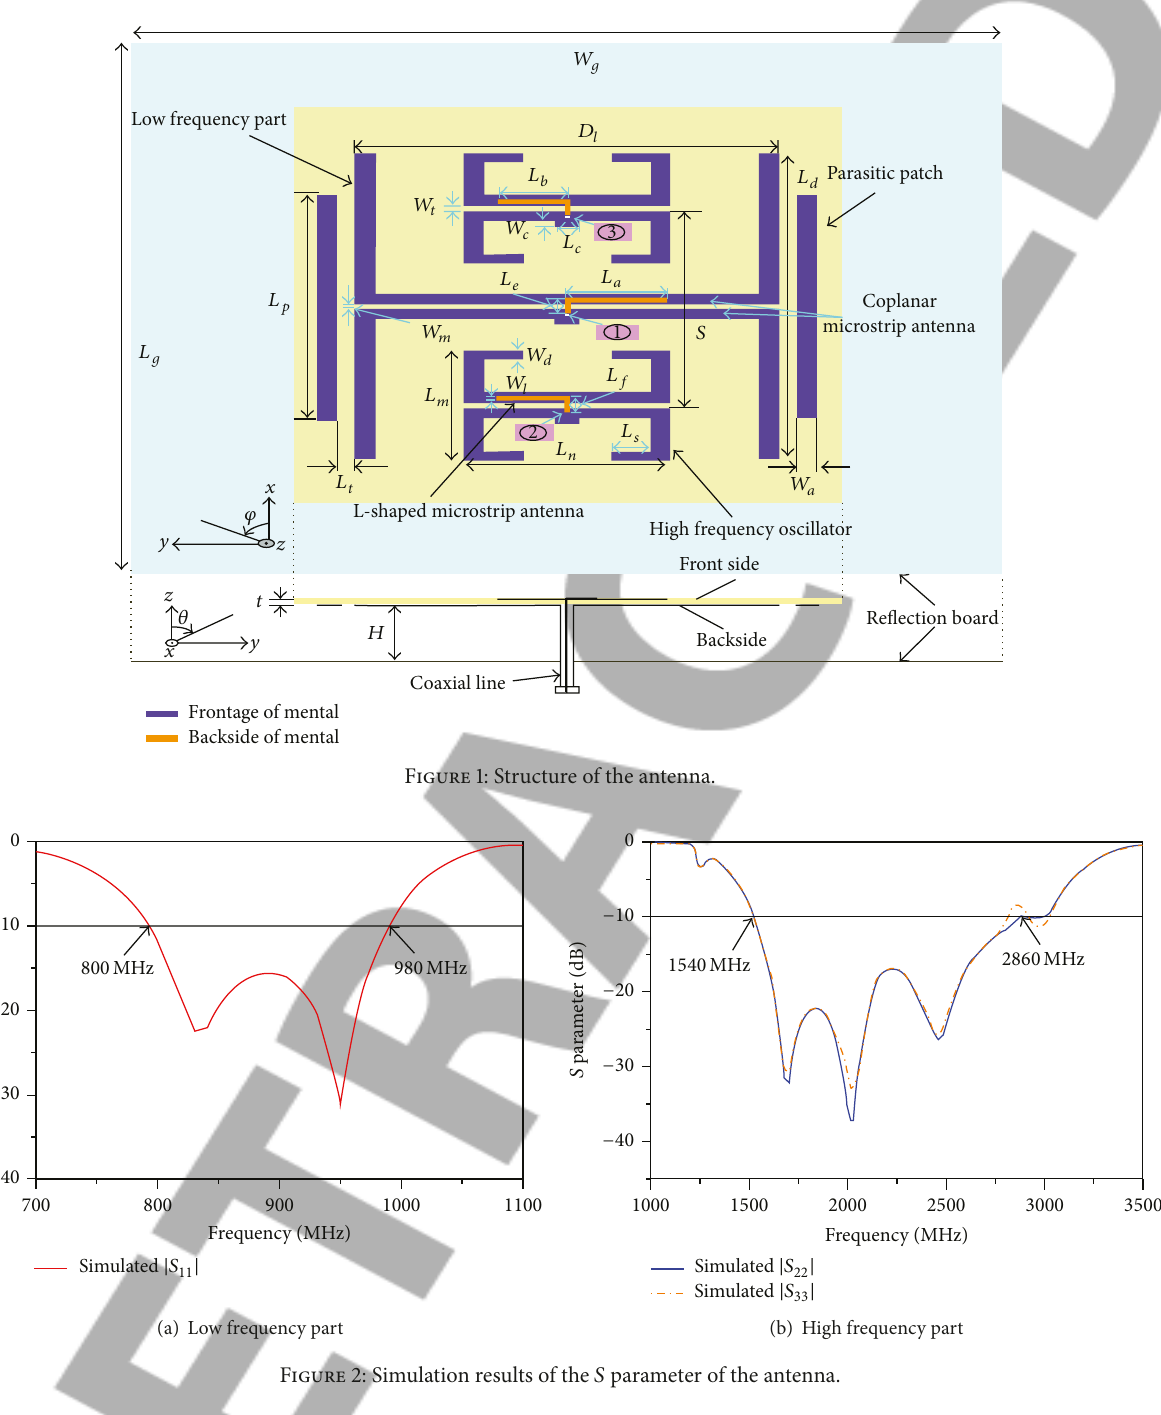
Figure 2: Simulation results of the 𝑆 parameter of the